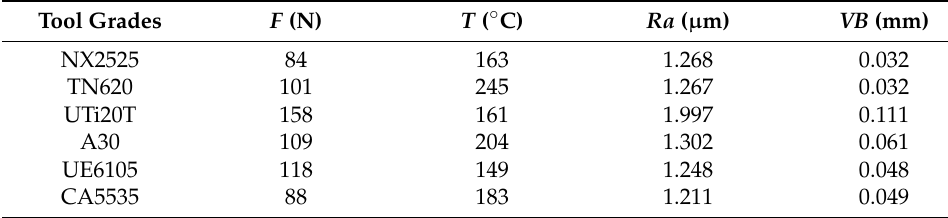
Table 4. Results of turning experiments at the cutting speed of 80